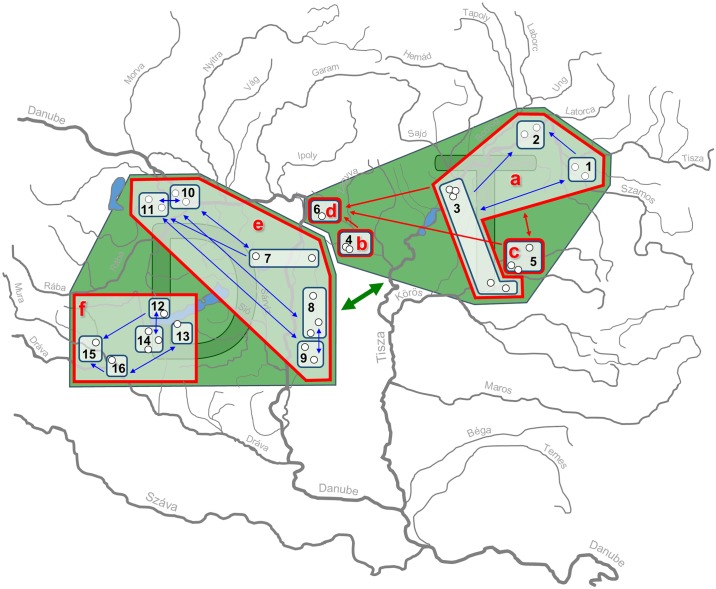
Migration within and among different clusters designated by hierarchical STRUCTURE analyses.Sites in the green areas belong to the same evolutionarily significant units (ESUs) identified by the 1st level of hierarchical STRUCTURE analysis. Sites framed by red and blue lines belong to the same conservation units (CUs) and management units (MUs) designated by the 2nd and 3rd level by STRUCTURE analyses respectively. Arrows directions show between cluster migrations, where the migration rate is >1 individual per generation. Arrow colouring corresponds to hieararchical levels. Open circles show sampling sites. Codes of clusters correspond to Fig 4.